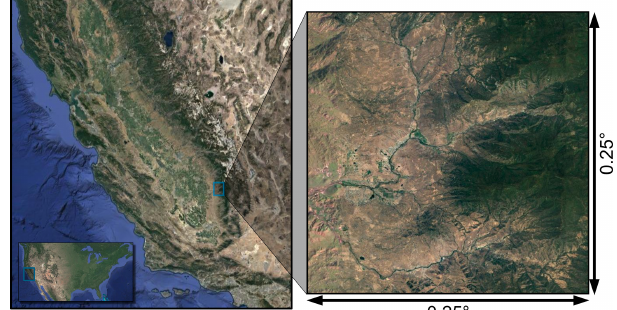
Figure 1. Test-bed site in the foothills of the southern Sierra Nevada in California used to develop, implement, and test the HMC algo- rithm. The region is characterized by strong heterogeneity in topog- raphy, climate, and soil properties leading to a complex multi-scale ecosystem spatial